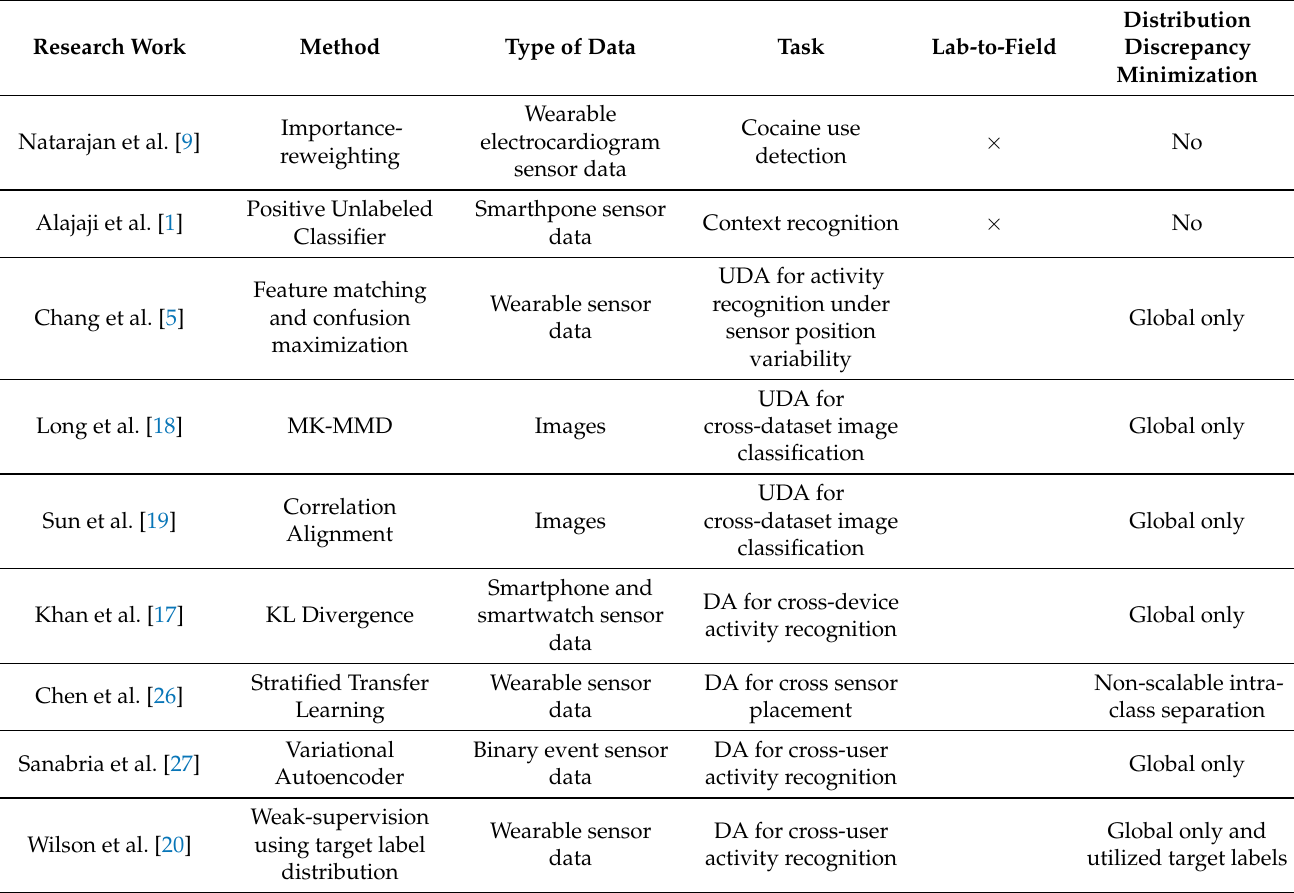
Table 3. Related work